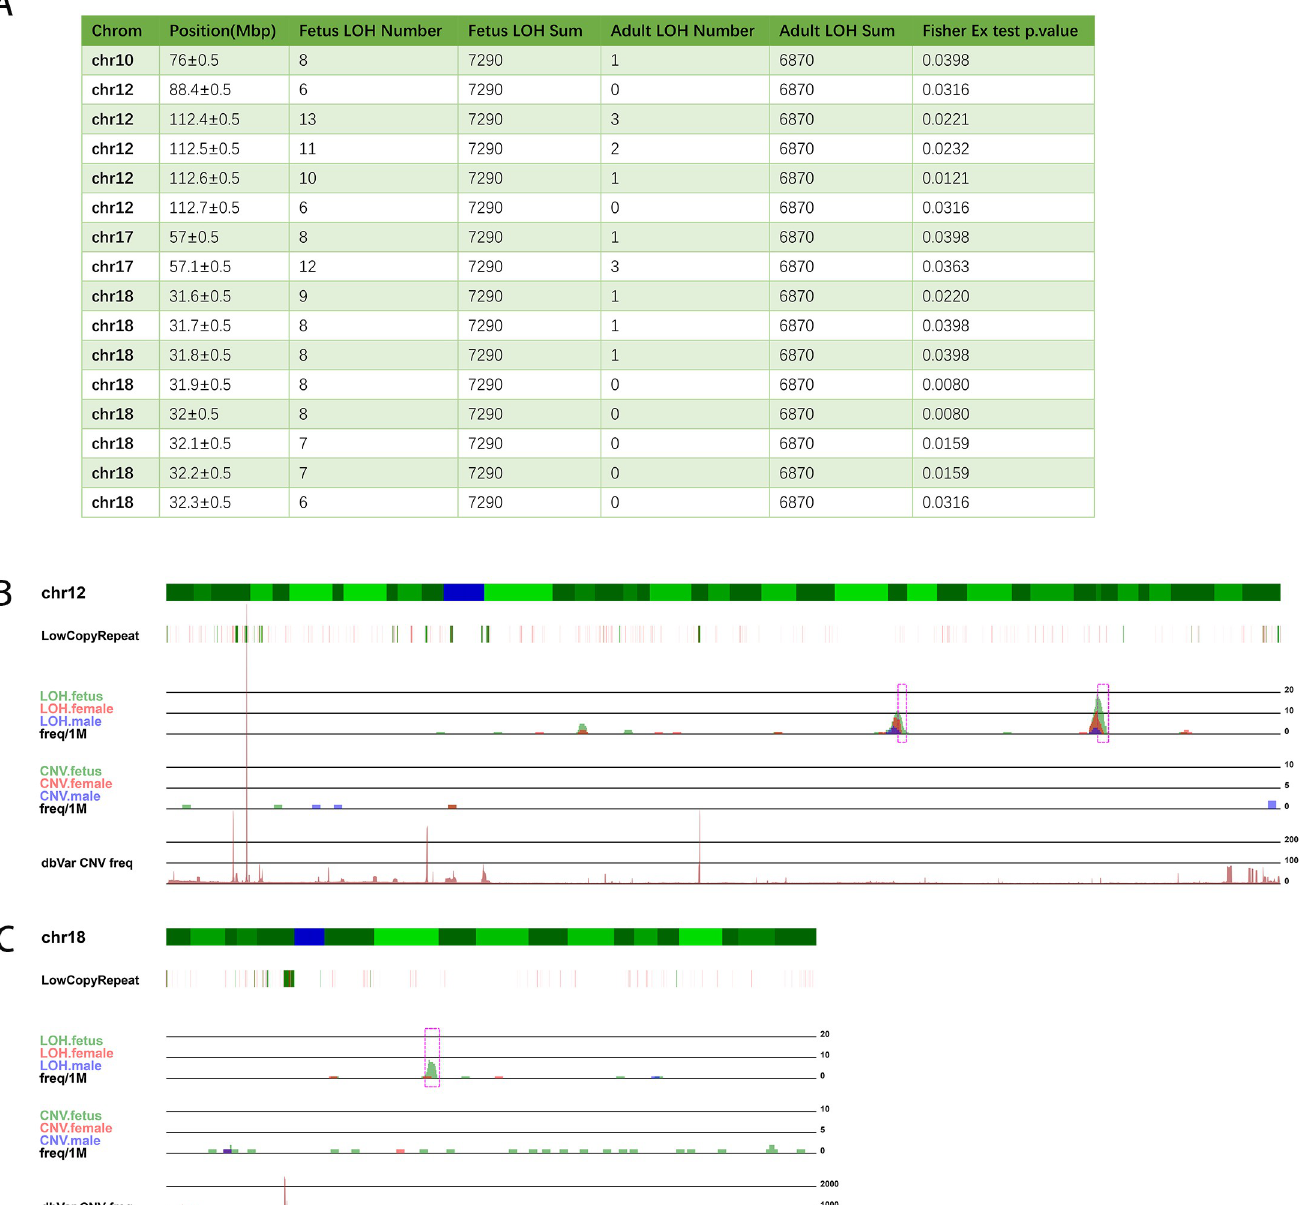
replication events of non-sister homologous chromatids couldn’t occur in gametes, so LOHs detected in the fetuses of non-consanguineous marriage parents might be formed after fertili- zation. If the LOH formed in embryonic cells after several mitotic cell cycles, the detection of LOHs would become difficult to be detected as the converted SNPs would only occur in a small proportion of cells. So the increased LOH number in ART-aborted fetuses indicates that the ART-aborted fetuses might have experienced more DNA DSBs during early embryo